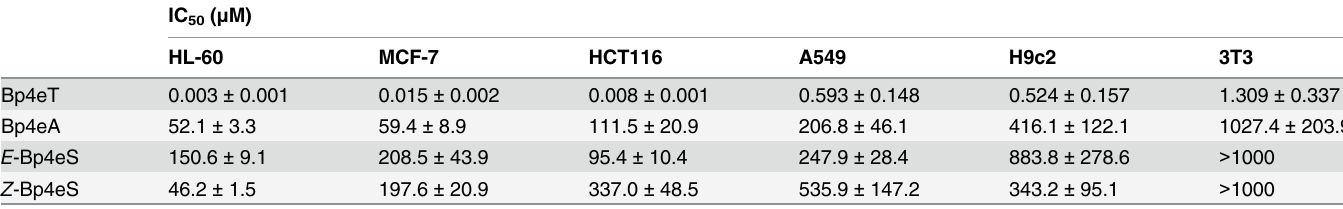
Table 1. Cytotoxic effects of Bp4eT and its metabolites against both neoplastic and non-cancerous cell lines.